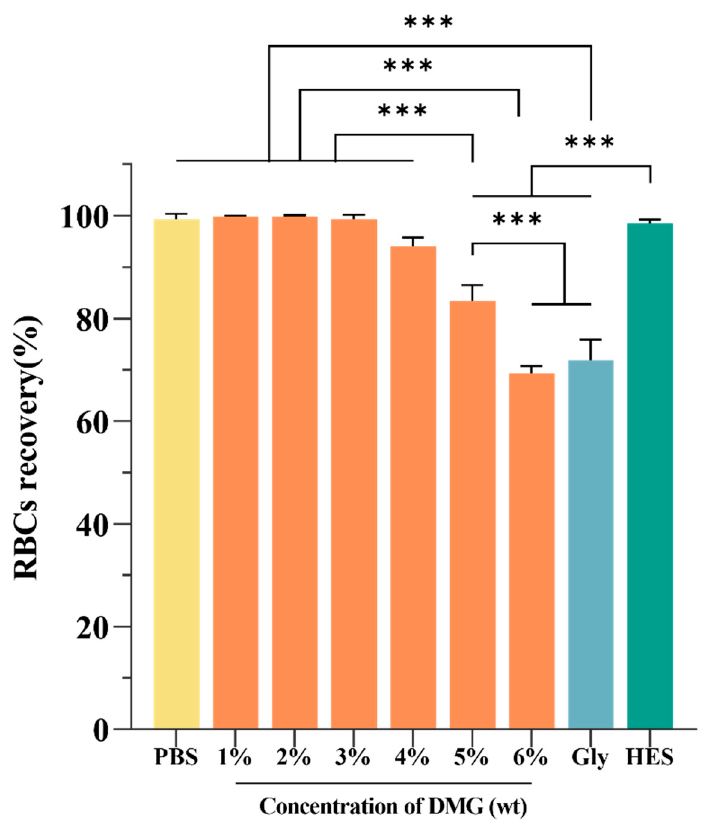
Figure 2. Biocompatibility test. The concentrations of Gly and HES were 20% and 13%, respectively. *** p < 0.001. *** p <